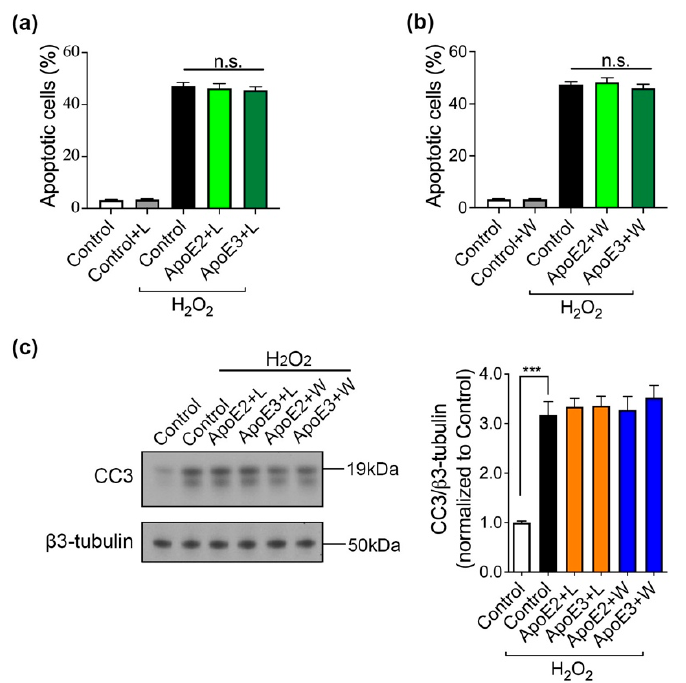
Figure 5. PI3K inhibitors abrogate the neuroprotective effects of ApoE2 and ApoE3. ( a ) Cell apoptosis was measured in the presence or absence of 10 µ M LY294002. ( b ) Cell apoptosis was measured in the presence or absence of 50 nM wortmannin. ( c ) The alterations in the expression levels CC3 were examined by Western blot; quantification of protein expression levels and normalized to the Control group. Values are means ± SEM of four independent experiments of each line. One-way ANOVA and Dunnett test used, *** p < 0.001 versus neurons co-treated with control medium and H 2 O 2 . n.s.: non-significant